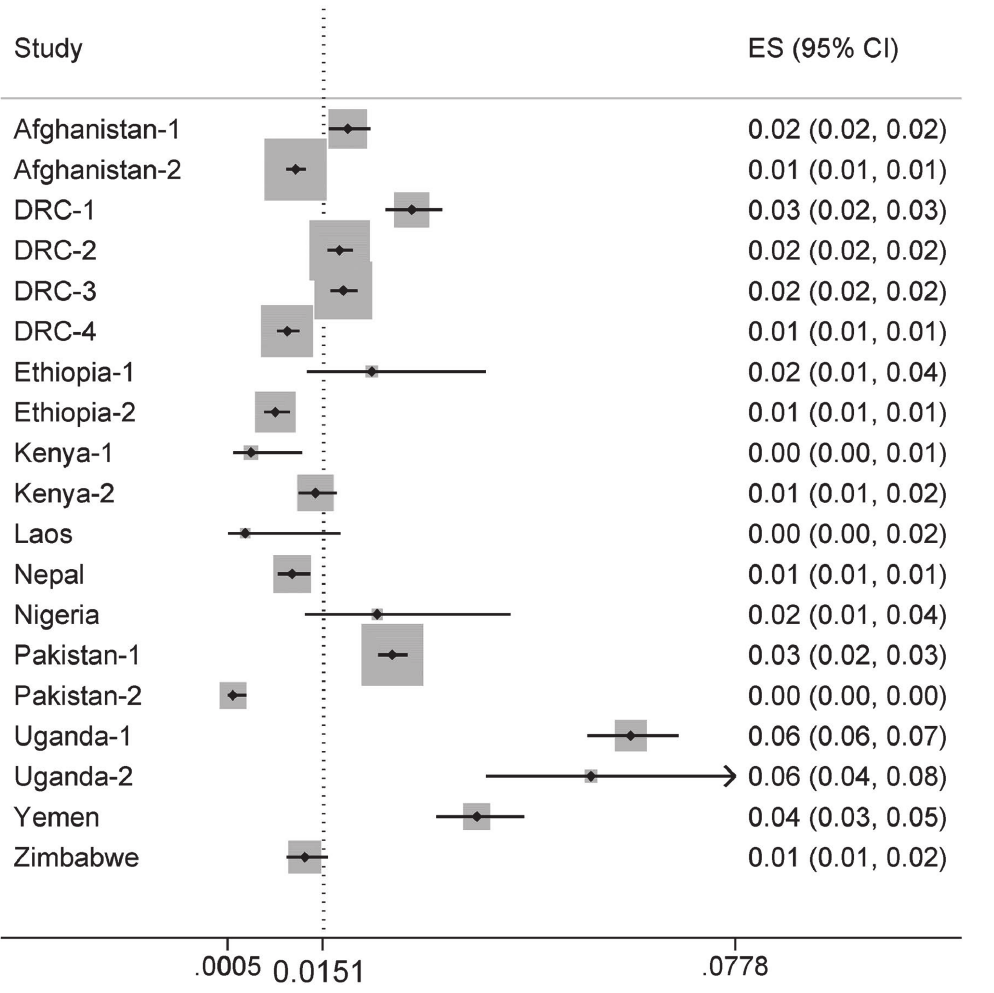
Fig 3. Forest plot of the proportion SS+TB among screened household contacts of TB